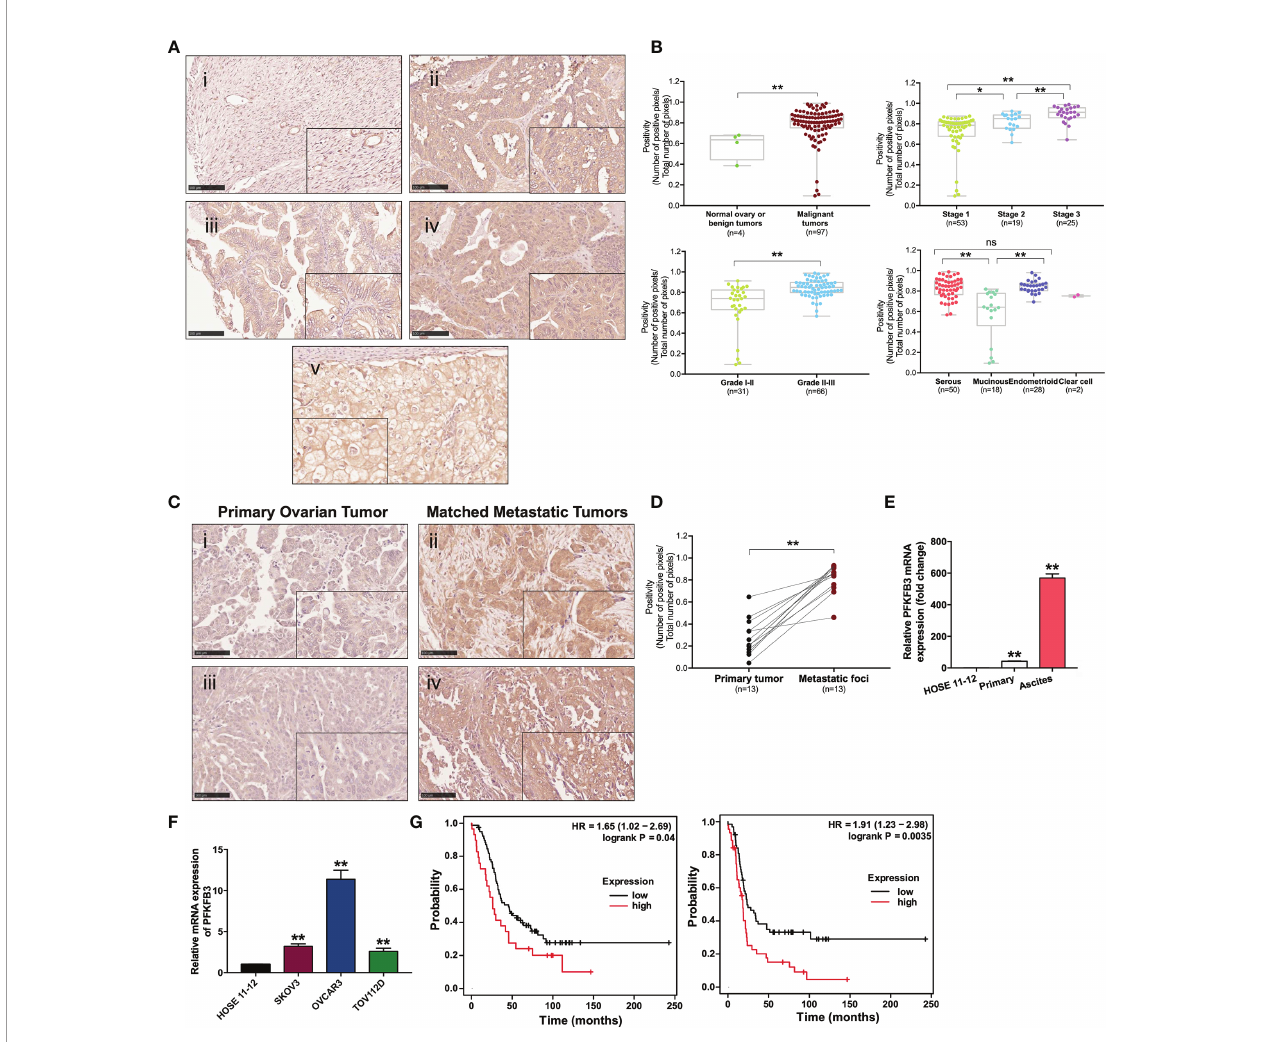
FIGURE 1 | Overexpression of PFKFB3 in ovarian cancer is correlated with metastasis and poor prognosis. (A) Representative images of PFKFB3 expression in (i) normal ovarian tissue, (ii) serous, (iii) mucinous, (iv) endometrioid and (v) clear cell subtypes of tumor samples on ovarian cancer TMA (OVC1021, Biomax) by IHC staining (scale bar, 100 m m). The insets highlight regions with higher magni fi cation. (B) Association of PFKFB3 with stage/grade/histotype in ovarian cancer. The graphs for stage and grade encompass all four histotypes. (C) Representative images of IHC staining for PFKFB3 expression in ovarian primary tumors (i, iii) and their metastatic foci (ii, iv; scale bar, 100 m m). (D) Bar chart showing PFKFB3 staining in 13 pairs of tissues. (E) Relative PFKFB3 mRNA expression in HOSE 11-12, primary cancer cells and matched ascites cancer cells from high-grade serous ovarian cancer, determined by qPCR. (F) PFKFB3 expression in HOSE 11-12 and ovarian cancer cell lines (SKOV3, OVCAR3, and TOV112D) at the mRNA level, determined by qPCR. (G) (left) Overall and (right) progression-free survival rates were analyzed with the log-rank test for PFKFB3 high/low groups of ovarian cancer patients obtained from GSE26193 (n = 107), by using the Kaplan-Meier plotter. (*p < 0.05, **p < 0.01; n.s., not signi fi